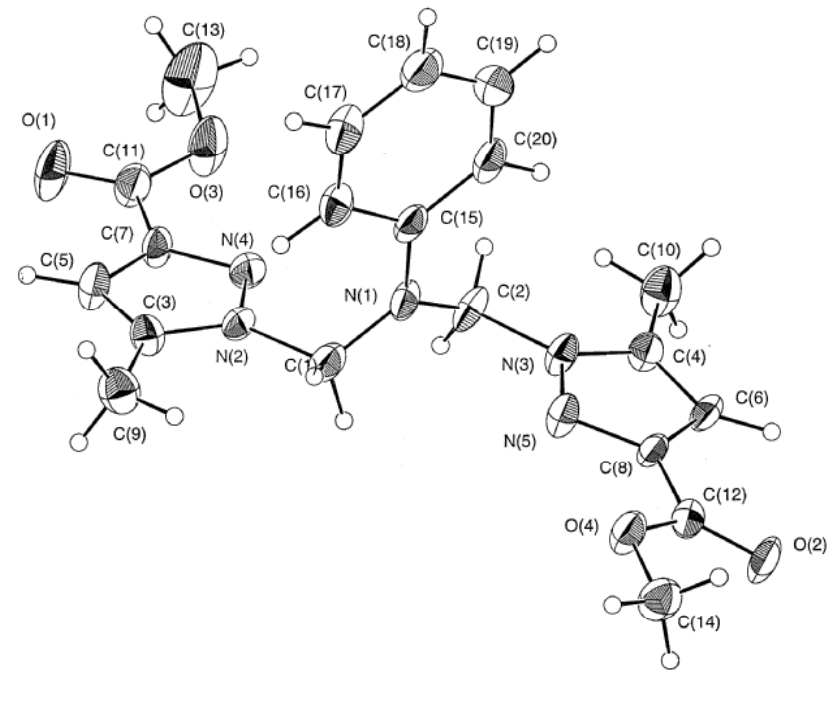
Scheme 2 : Molecular structure of the title compound with atom labelling.